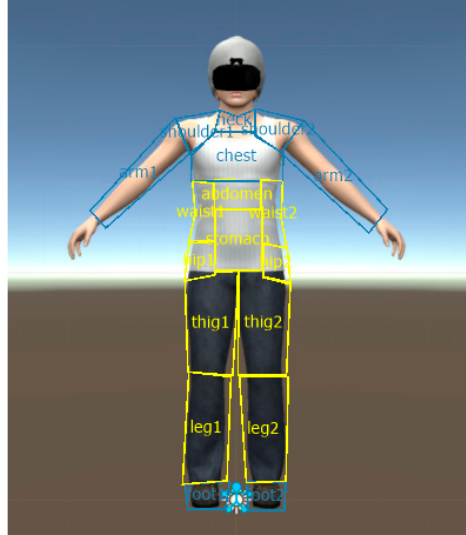
Figure 3. Weight-related and non-weight-related areas of interest (AOIs). Weight-related and non- weight-related areas of interest (AOIs) (yellow and blue areas respectively) in the female avatar, used by the OGAMA software to process body-related attentional bias (both complete fixation time and number of fixations).